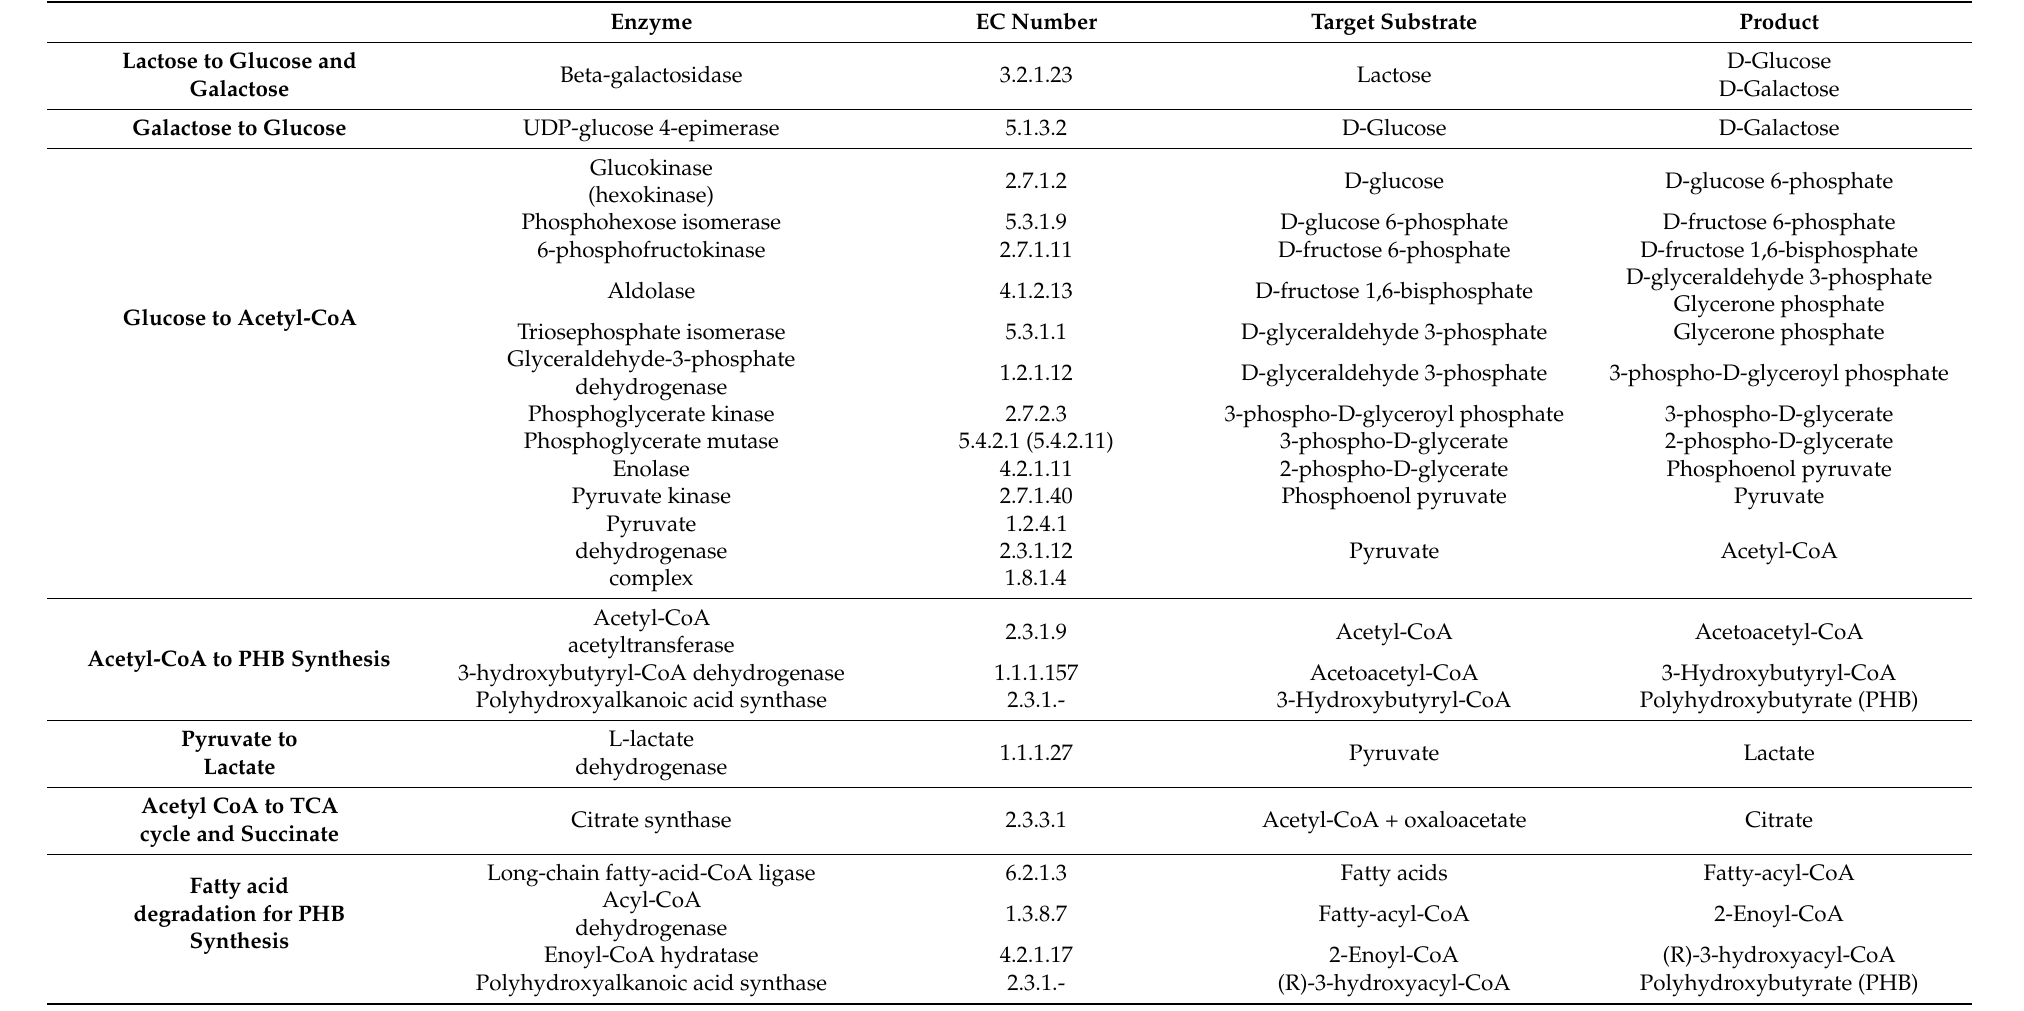
Table 2. The annotated B. marmarensis enzymes and their target substrates in the PHB synthesis pathway.